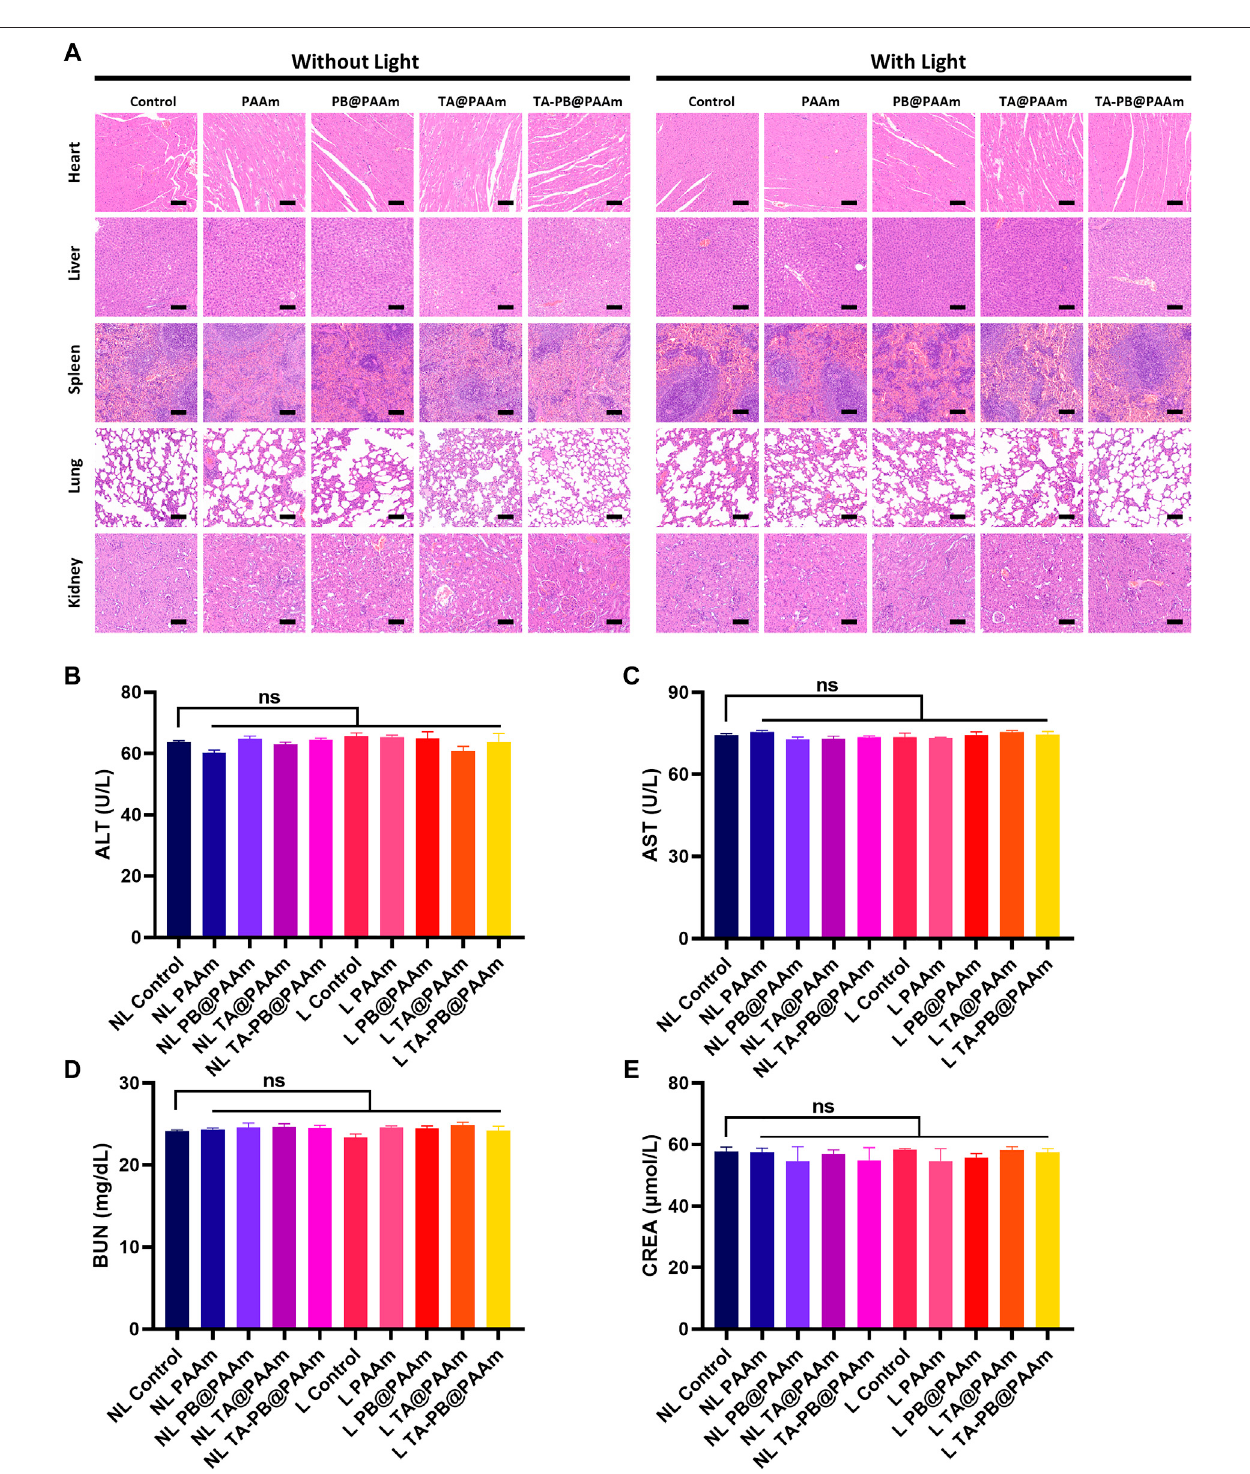
FIGURE8| aHandEstainingofheart,liver,spleen,lungandkidney.Scalebar (cid:1) 100 μ m. bResultsofALT.cResultsofAST.dResultsofBUN.eResultsofCREA. Data are mean ± SD (n (cid:1) 3, ns (cid:1) no statistical difference).